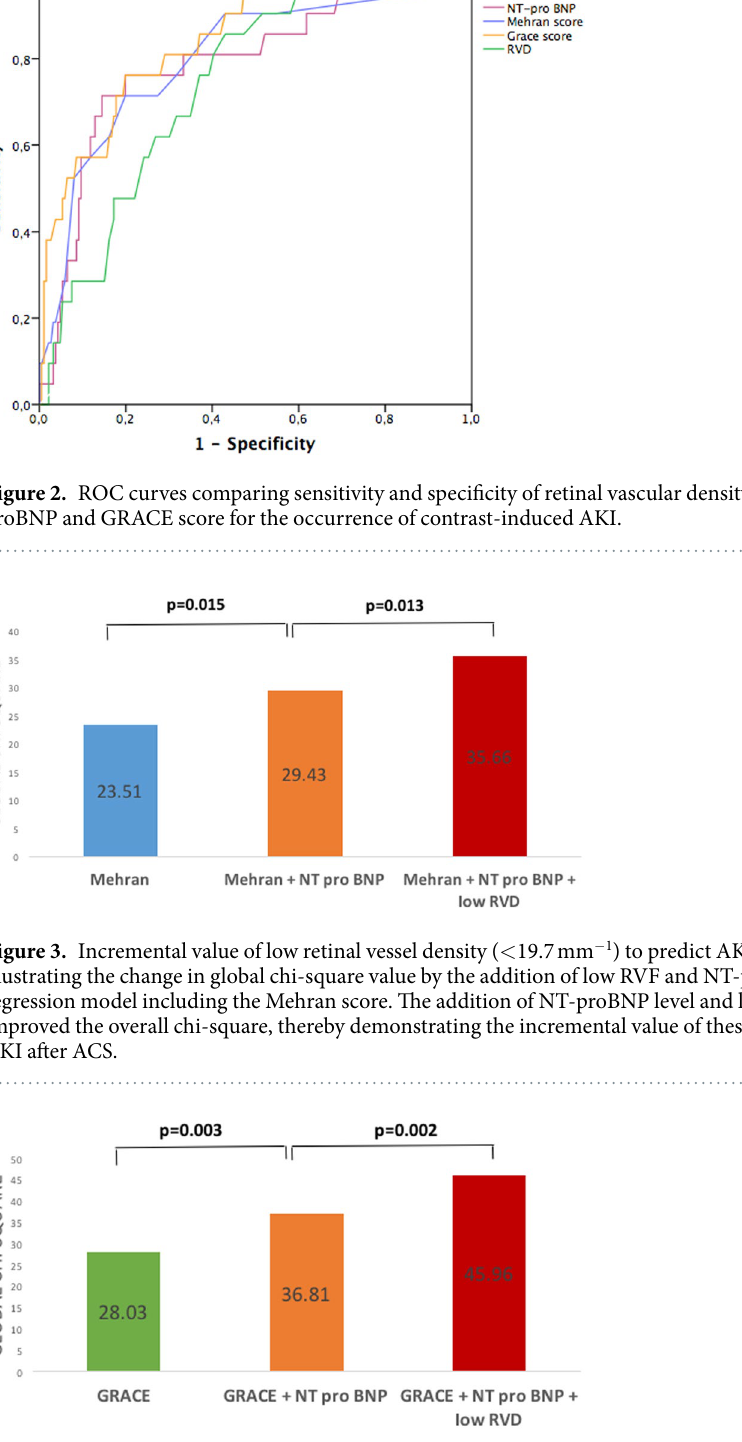
Figure 4. Incremental value of low retinal vessel density ( < 19.7 mm − 1 ) to predict AKI after ACS. Bar graphs illustrating the change in global chi-square value by the addition of low RVF and NT-proBNP level to a logistic regression model including the GRACE score. The addition of NT-proBNP level and low RVD significantly improved the overall chi-square, thereby demonstrating the incremental value of these parameters to predict AKI after